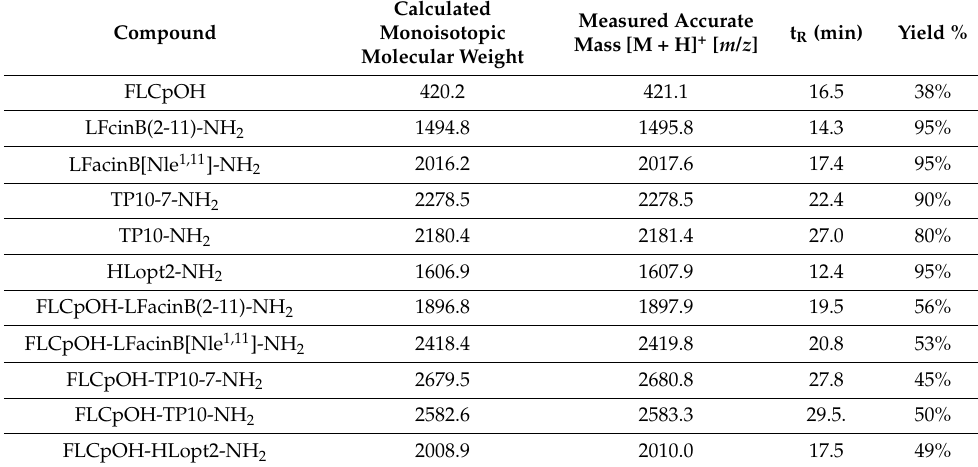
Table 1. Physicochemical properties of FLCpOH, the peptide conjugates and their components. Calculated Compound Monoisotopic Molecular